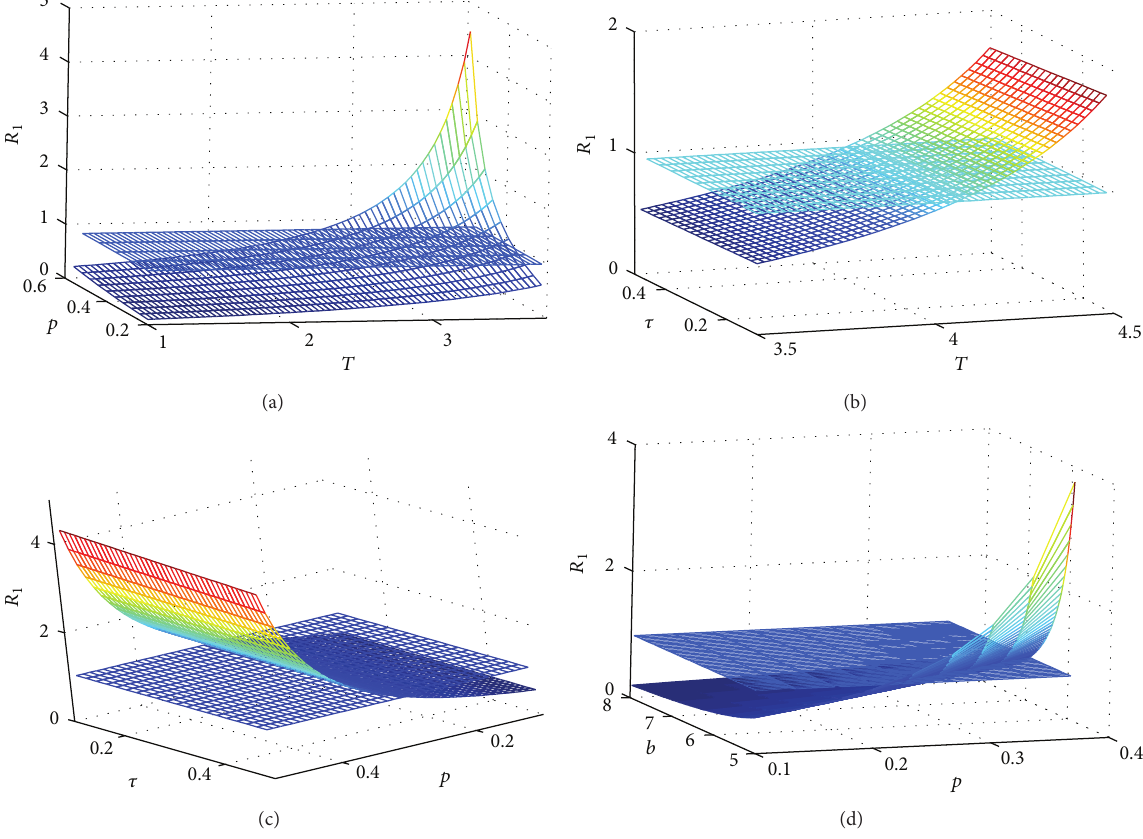
Figure 3: The influence of some key parameters on the threshold level 𝑅 1 ; the other parameter values are as follows: 𝑟 = 3, 𝜔 = 0.2, 𝑘 = = 0.1, 𝑑 = 0.2, 𝑑 = 0.15 , and 𝑎 = 5. (a) 𝑏 = 7, 𝜏 = 0.2, 𝑇 : 1 → 3.8, 𝑝 : 0.2 → 0.6 ; (b) 𝑏 = 7,𝑝 = 0.25, 𝑇 : 3.5 → 4.5, 𝜏 : 0.1 → 0.5 ; 0.2, 𝑑 1 2 3 (c) 𝑏 = 7,𝑇 = 4, 𝑝 : 0.1 → 0.5, 𝜏 : 0.1 → 0.5 ; (d) 𝜏 = 0.2, 𝑇 = 3, 𝑏 : 5 → 8, 𝑝 : 0.1 → 0.4 .